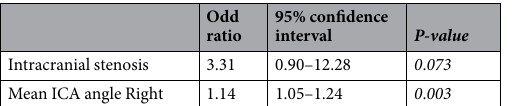
Table 3. Multivariate logistic regression analysis for factors of risk of ischaemic stroke. ICA: internal carotid